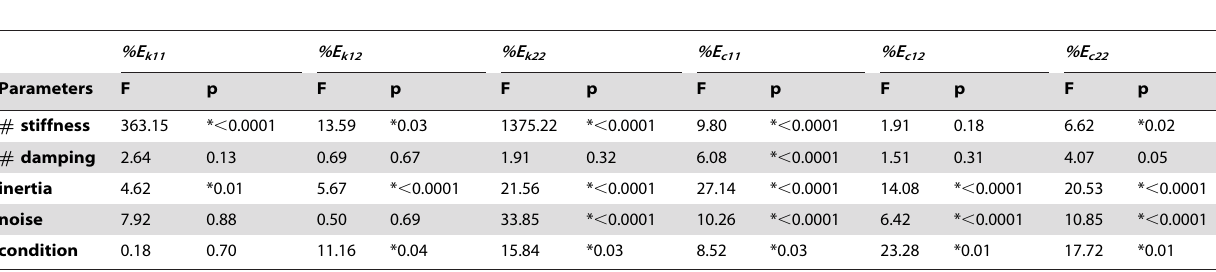
Table 7. Repeated measures ANOVA for the percentage RMS error using force full regression among different inertial methods with stiffness and damping time-profiles as random factors along the interval 2.5–5 s.